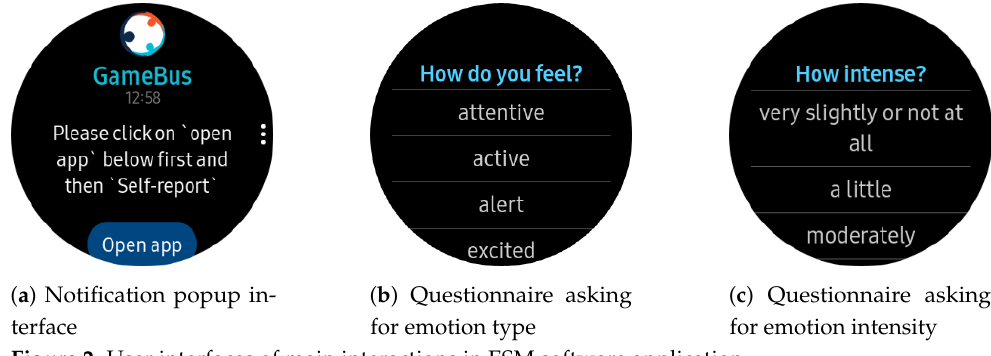
Figure 2. User interfaces of main interactions in ESM software